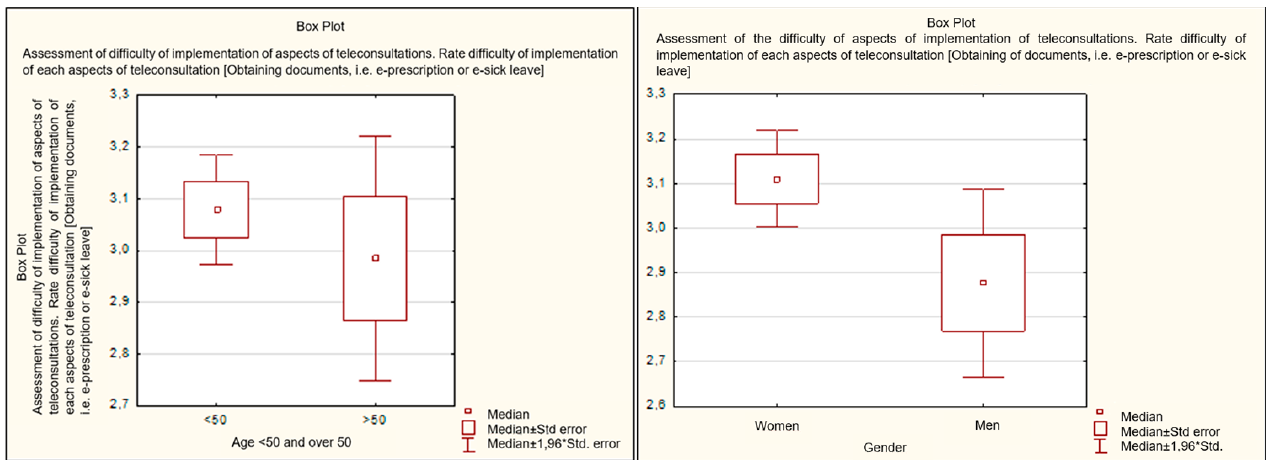
Figure 2. Assessment of the difficulty of obtaining an e-prescription by age and gender.